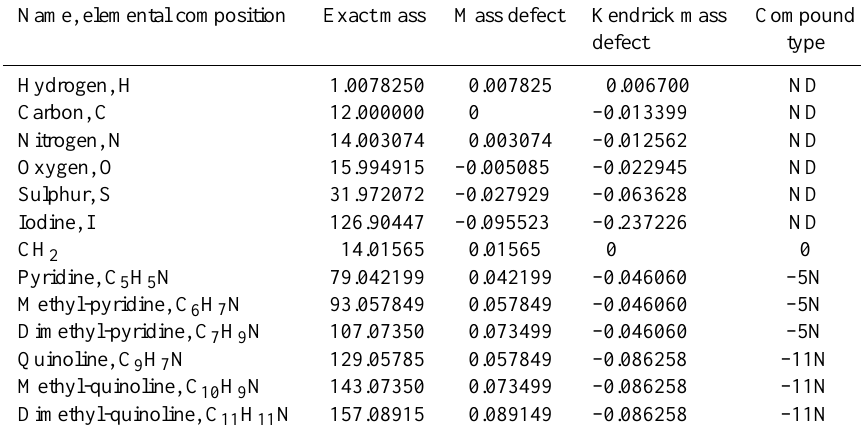
Table 3. Exact masses, mass defects, Kendrick mass defects and compound types for selected elements and molecules. Name, elemental